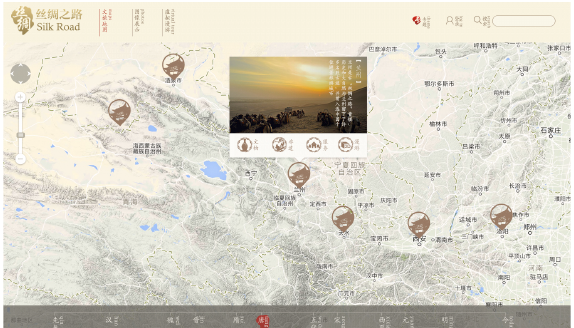
Figure 3: Example on interface design for the Time and space maps of the website